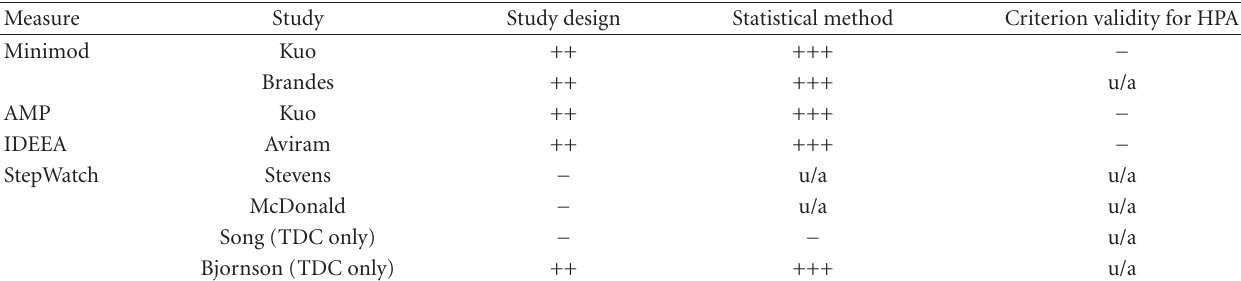
Table 3: Evidence of criterion